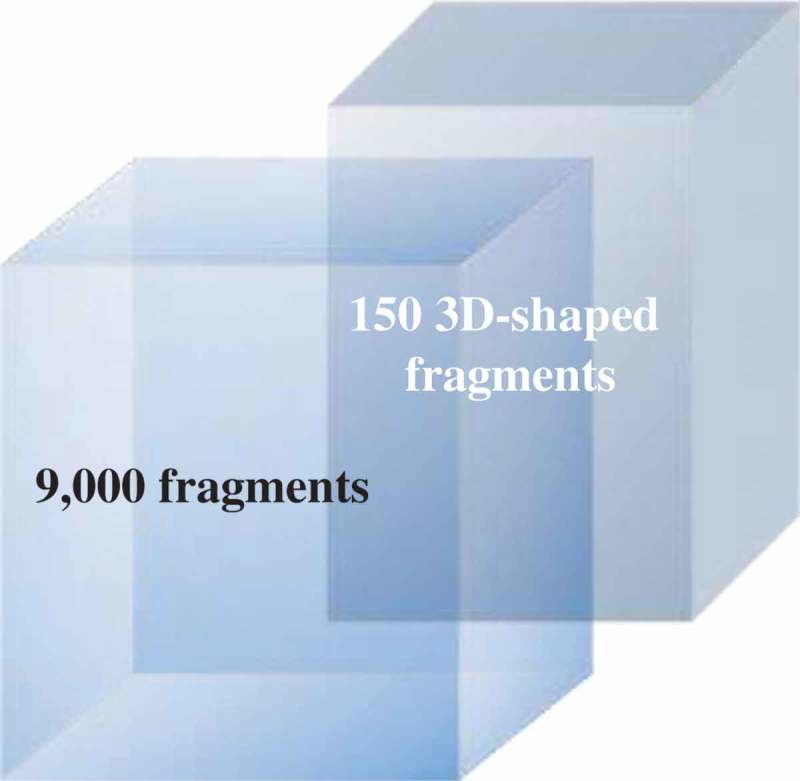
Shape (fraction of Csp3) and natural product likeness analysis of the generated fragment library (150 members) and current Novartis in-house fragment library (9,000 members) [13]. There is only minor overlap, the new small fragment library occupies unique chemical space. Adapted from reference [13].